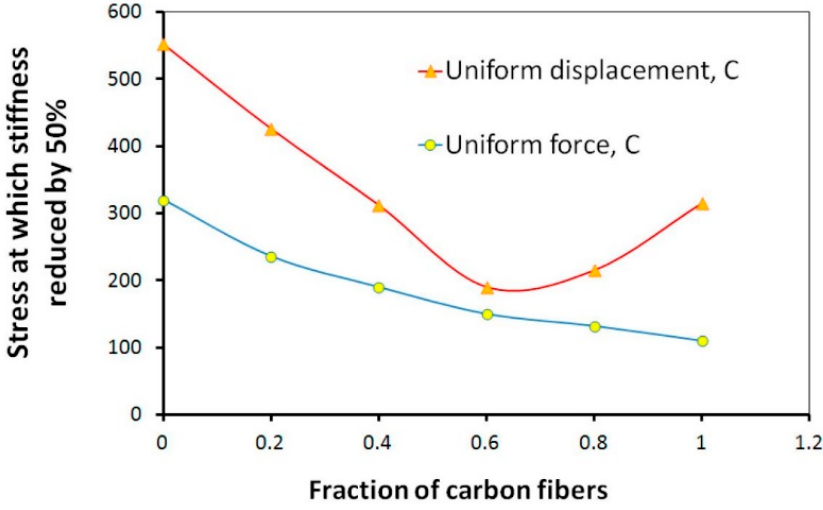
Figure 6. Critical stress against carbon fiber fractions in hybrid composites [43].